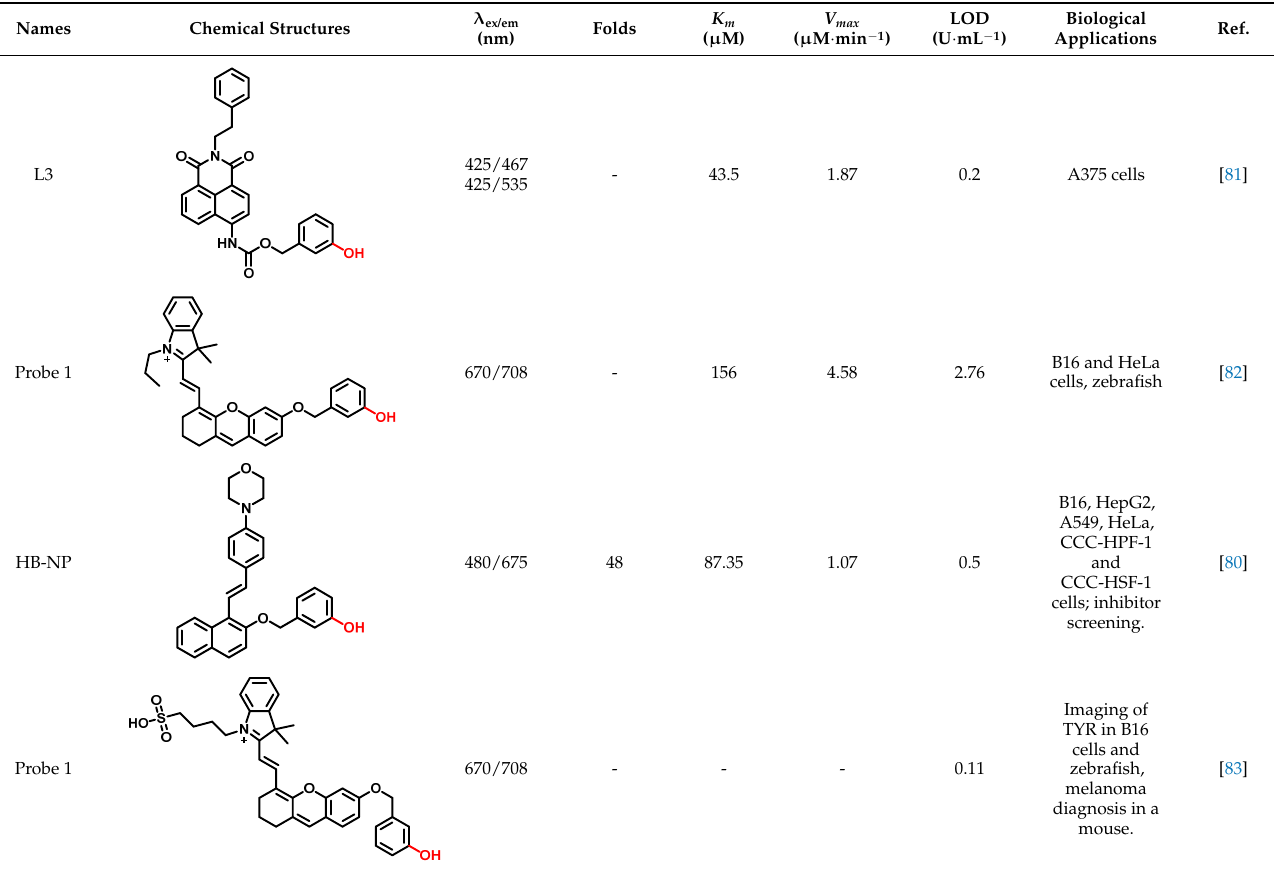
Figure 7. Several strategies reported for designing the fluorescent substrates of TYR. ( a ) Some typical warheads of fluorescent probe for TYR detection. ( b ) Two sensing mechanisms of OFF-ON probes towards TYR. Table 3. Fluorescent substrates of TYR.